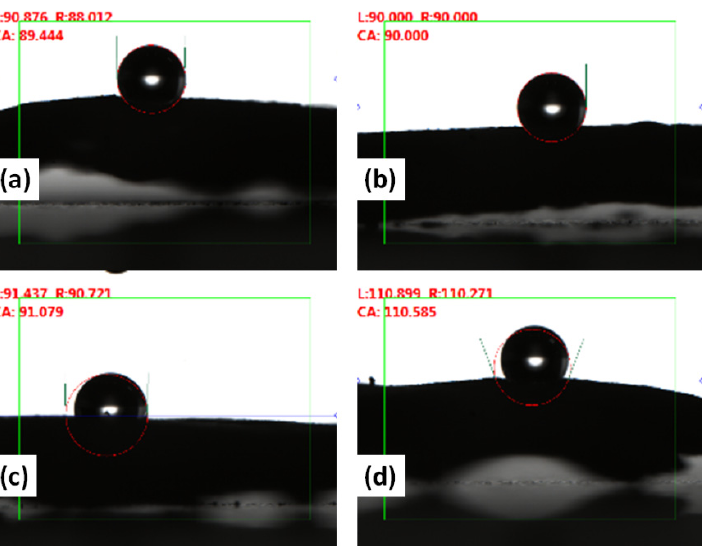
Figure 11. Contact angle for the prepared electrode at PVDF concentration ( a ) 5%, ( b ) 7.5%, ( c ) 10%, and ( d )